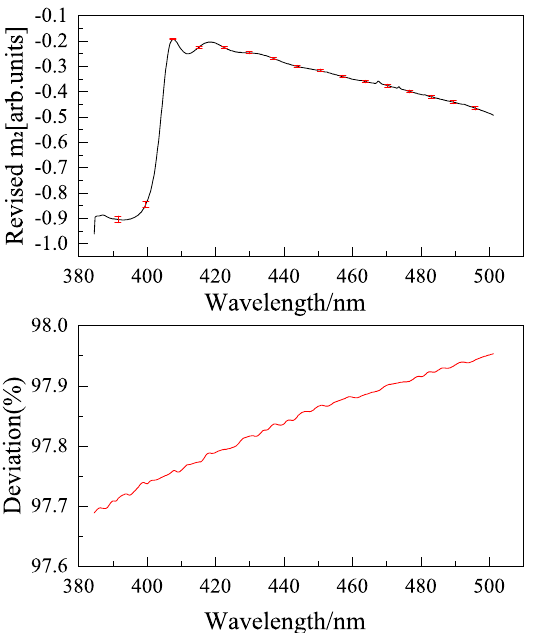
Figure 19. Comparison of Mueller matrix element m 2 for channel 2 before and after correction for UV hyperspectral